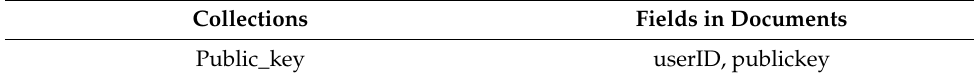
Table 1. Public key collection in database.